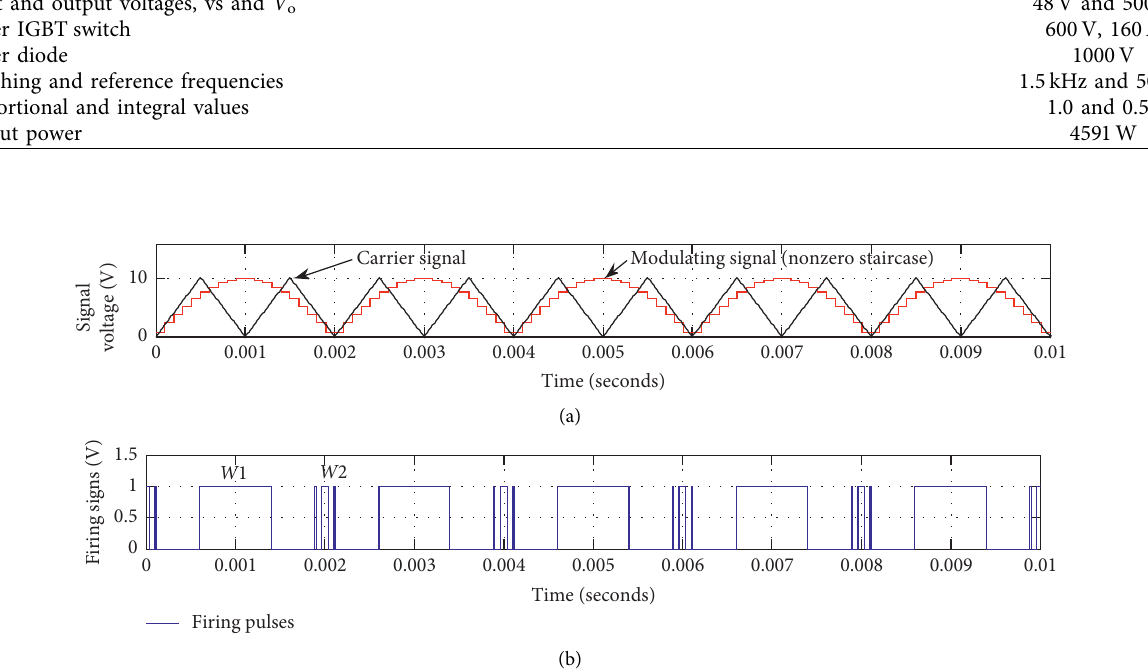
Figure 9: Nonzero staircase modulation